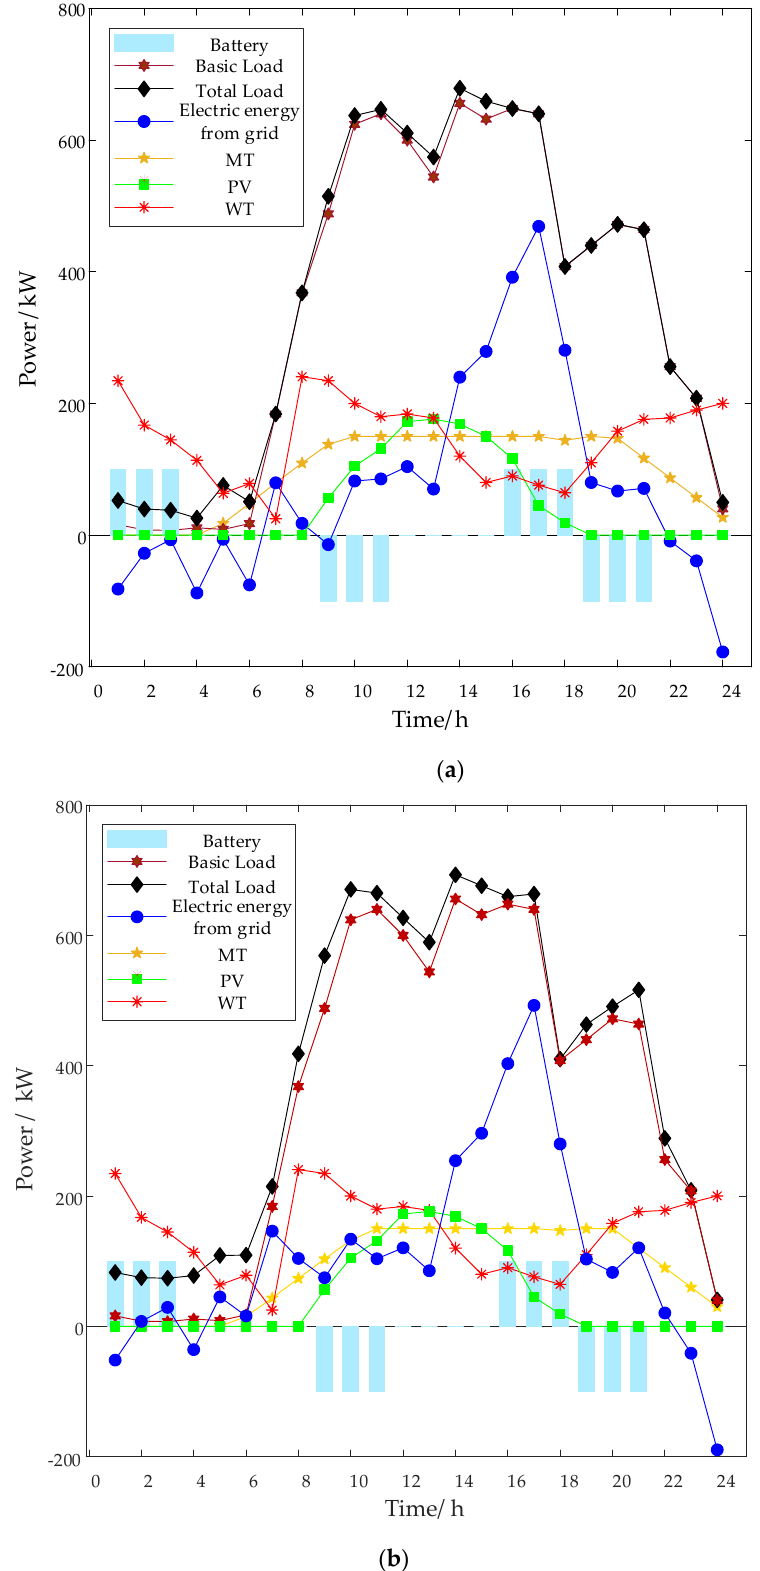
Figure 2. The power output on the electric bus before and after optimization: ( a ) before optimization; ( b ) after optimization.